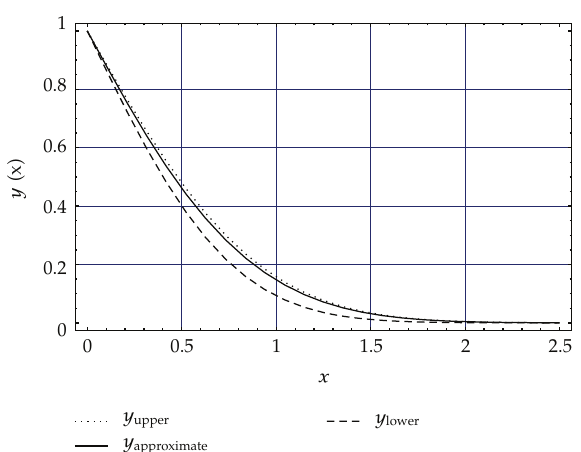
Figure 1: Computational results of y (cid:4) x (cid:3) , lower and upper solutions for Example